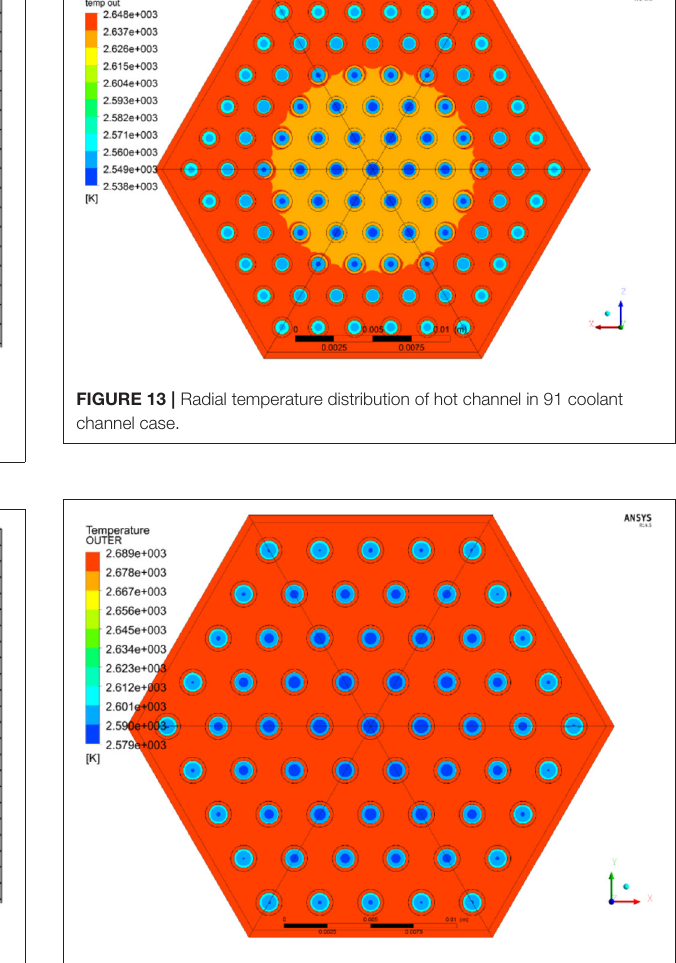
FIGURE 14 | Radial temperature distribution of hot channel in 61 coolant channel